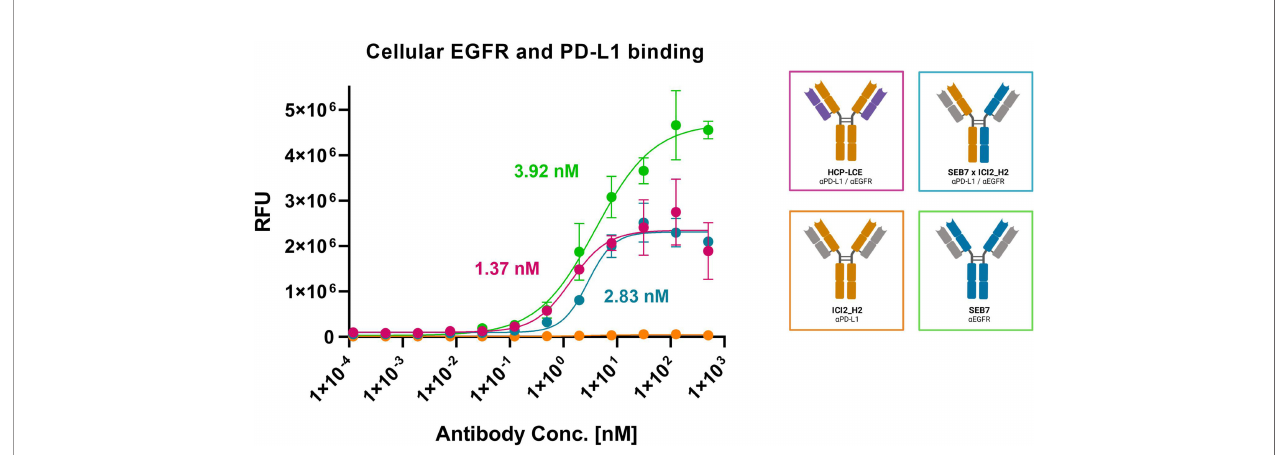
FIGURE 6 | Cell binding of EGFR and PD-L1 on A431 cells. Cell titration of HCP-LCE (pink), ICI2_H2 (orange), SEB7 (green) and the bispeci fi c construct (blue) on EGFR/PD-L1 double positive A431 cells. A variable slope four-parameter fi t was utilized to fi t the resulting curves. EC 50 values: HCP-LCE, 1.37 nM; SEB7, 3.92 nM; SEB7xICI2_H2, 2.83 nM. All measurements were performed in triplicates, and the experiments were repeated at least three times, yielding similar